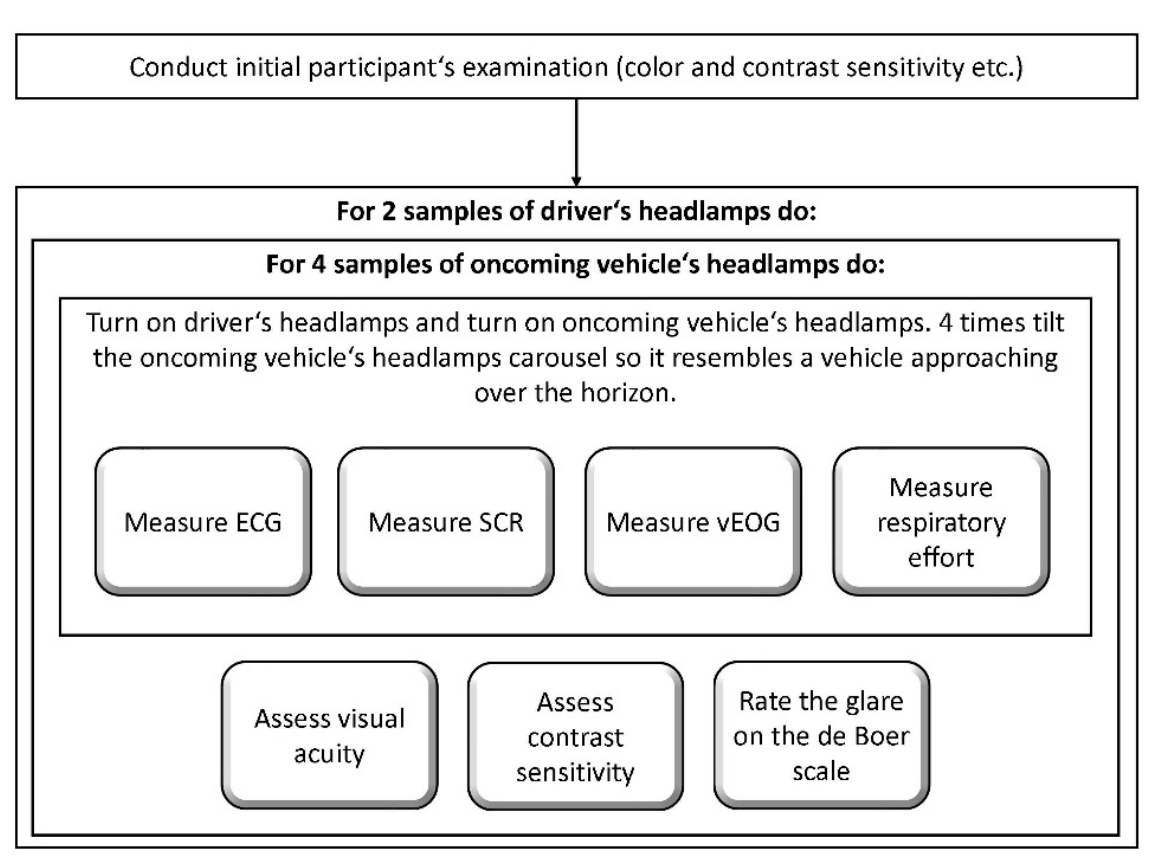
Figure 3. Experimental procedure.